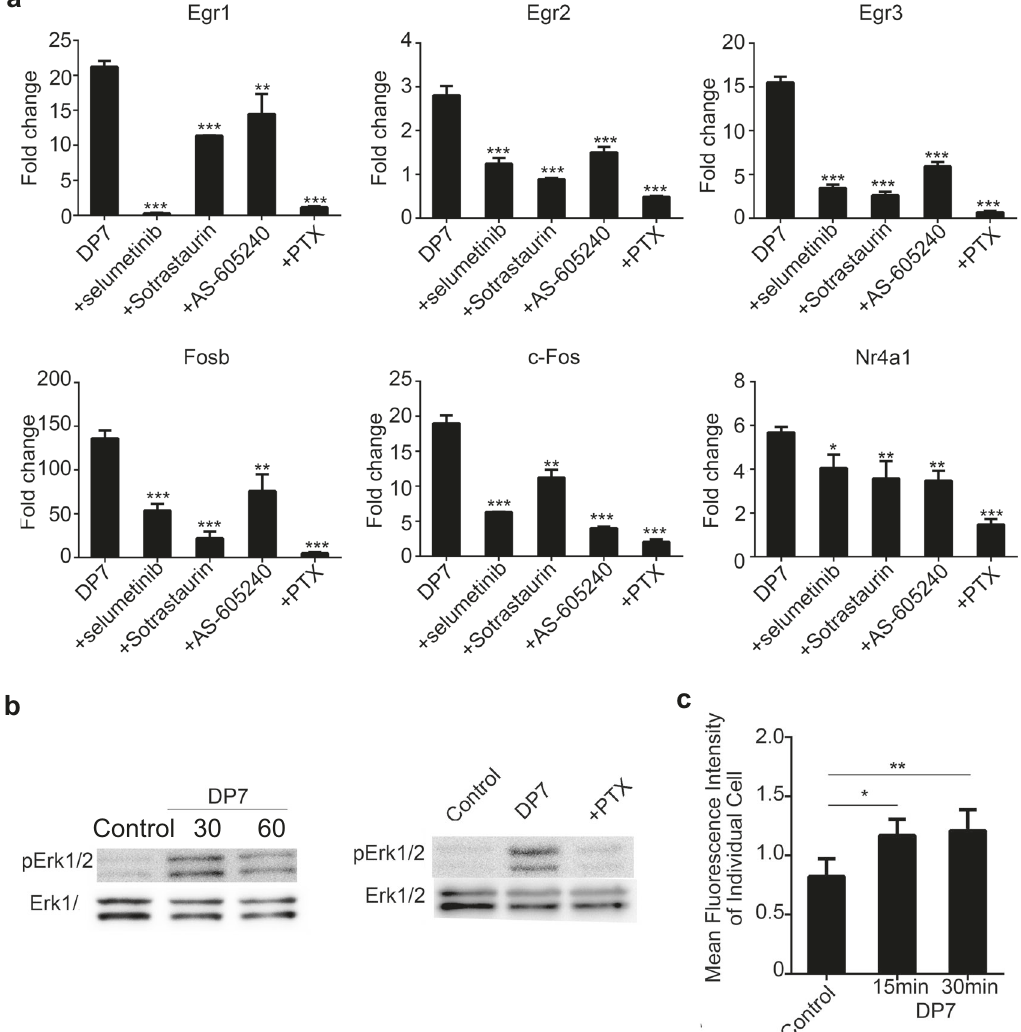
Fig. 6 Signaling pathways involved in DP7 activity. a JAWSII cells were pretreated with chemical inhibitors, stimulated with DP7 (40 μ g/ml) for 30 min, and then harvested for RT-qPCR analysis. Data are representative of three experiments with three replicates each. Statistical analyses were done using the t-test. Bars represent means + SEM. b JAWSII cells were pretreated with PTX and then stimulated with the peptide DP7 for 30 and 60 min. Erk1/2 phosphorylation was detected by western blotting. c JAWSII cells were stimulated with the peptide DP7 for 15 and 30 min. Intracellular Ca 2 + levels were measured with a Celligo ® image cytometer; control indicates the nonstimulated group. Bars represent means and SEM. * P < 0.05, ** P < 0.01, *** P <